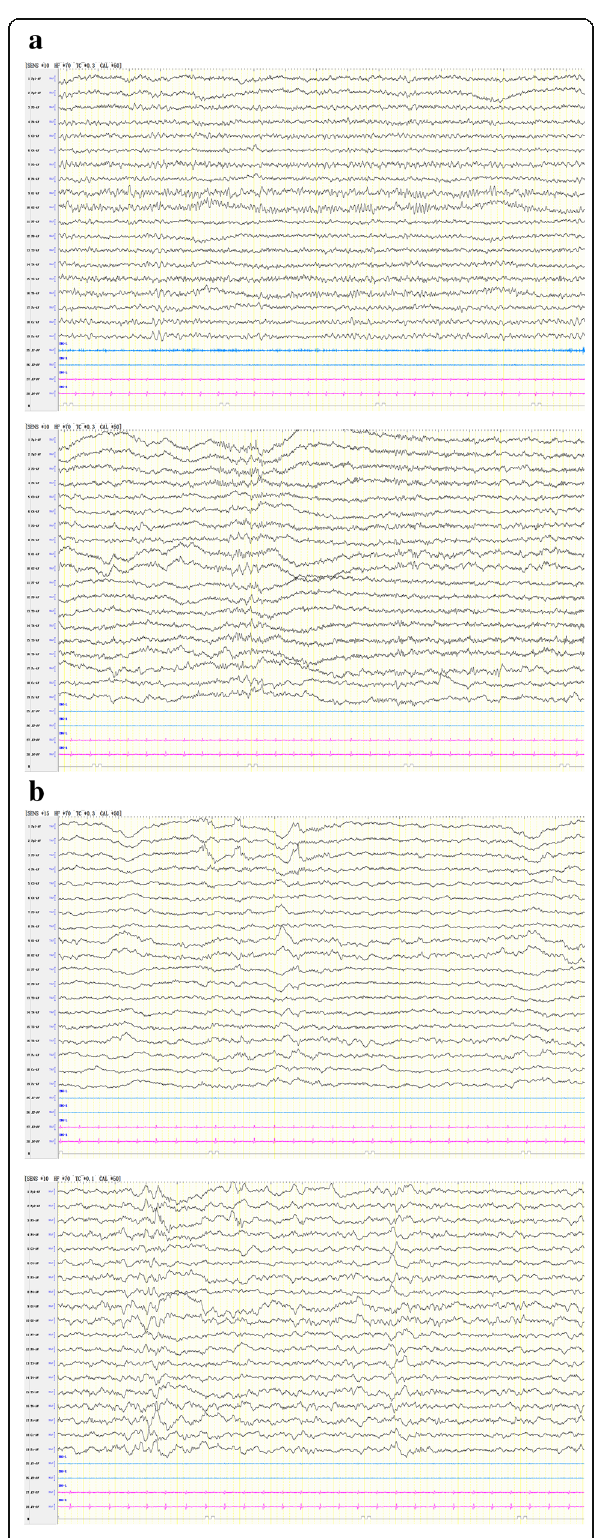
Fig. 4 EEG recordings obtained after half a month. a EEG background appears normal. b Interictal EEG shows few spike waves and sharp waves in the sleep stage in the left forehead. EEG,